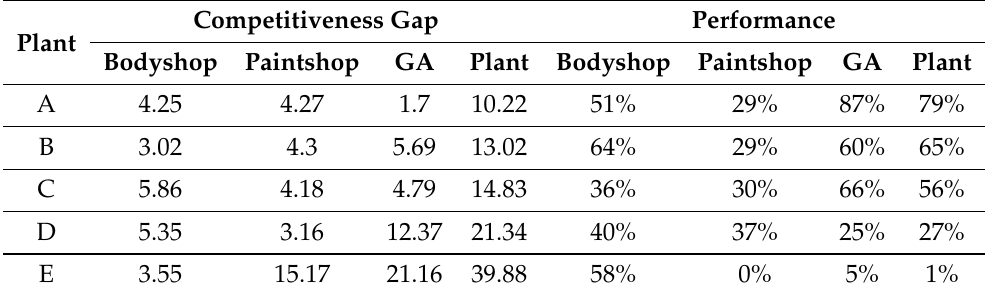
Table 1. Competitiveness gap and performance